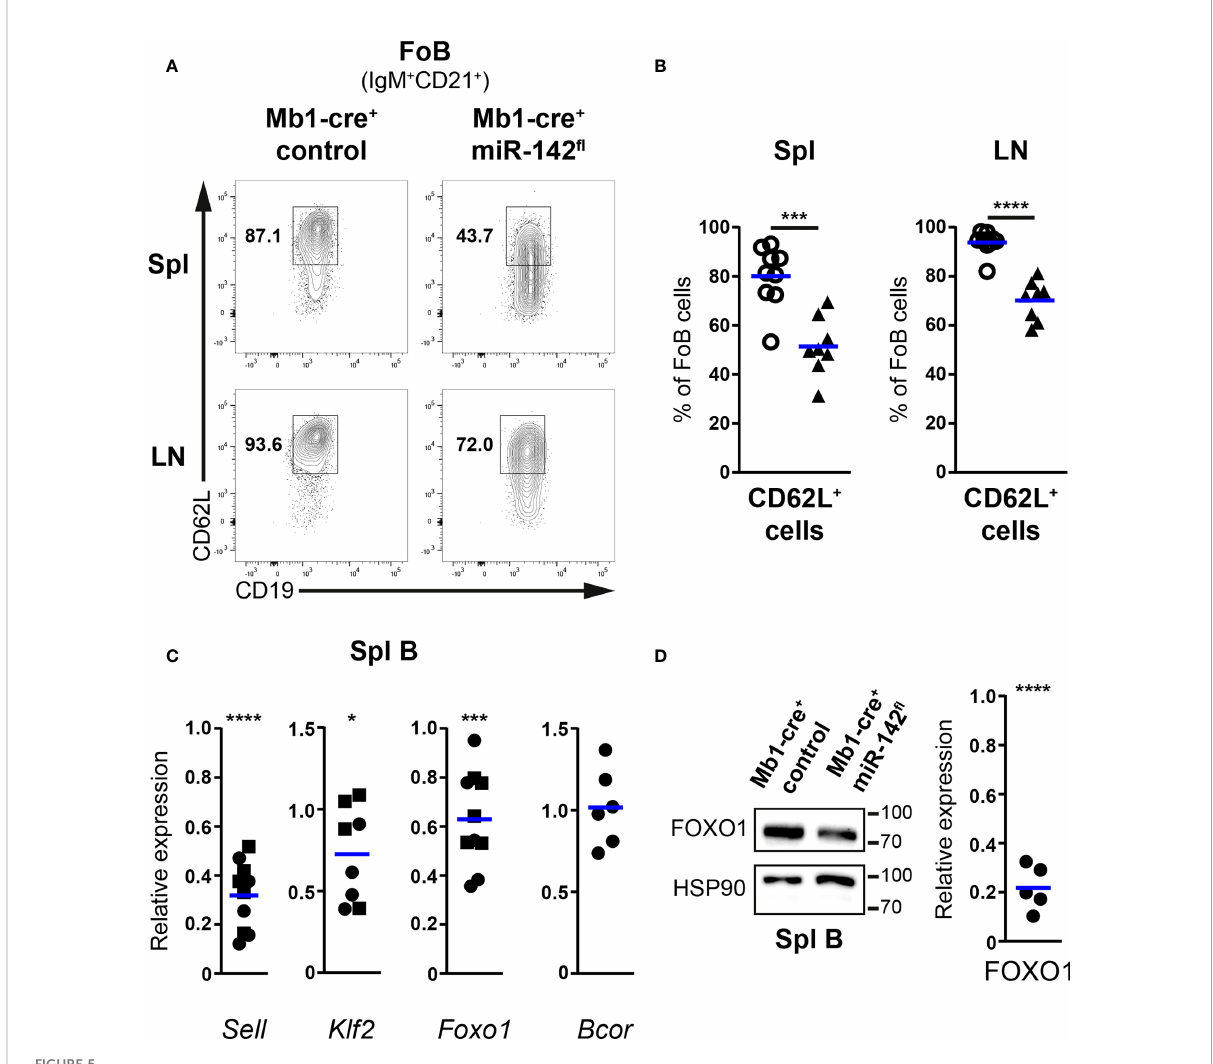
FIGURE 5 CD62L expression is impaired in follicular B cells of Mb1-cre + miR-142 fl mice. (A) fl ow cytometry of CD62L + cells within IgM + CD21 + CD19 + B220 + CD93 – follicular B (FoB) cells in the spleens (Spl) and lymph nodes (LN) of Mb1-cre + control and Mb1-cre + miR-142 fl mice. (B) Proportions of CD62L + Fo B cells in Spl and LN of Mb1-cre + ( ○ ) and Mb1-cre + miR-142 fl ( ▲ ) animals. n = 8-9 per group in 9 independent experiments. (C) Real-time PCR of Sell , Klf2 , Foxo1 and Bcor mRNA levels in magnetically-puri fi ed splenic B cells from Mb1-cre + miR-142 fl mice. Normalized to Hprt transcript levels and to their respective expression in Mb1-cre – ( n=4-5 , ◼ ) and Mb1-cre + ( n=4-6 , ● ) controls. Cumulative of 15 independent pairs of mice. (D) Left: Western blotting of FOXO1 and loading control HSP90 in splenic B cells magnetically-isolated from Mb1-cre + and Mb1-cre + miR-142 fl mice. Right: Quanti fi cation of FOXO1 protein levels in splenic B cells from Mb1- cre + miR-142 fl animals. Normalized to the expression of HSP90 and to the relative levels of FOXO1 in Mb1-cre + controls. n = 5, pooled from 5 independent pairs of mice. Each symbol represents one mouse (B) or a ratio between a pair of control and mutant animals (C, D) . (B – D) Horizontal blue lines indicate means. *, P ≤ 0.05; ***, P ≤ 0.001; ****, P ≤ 0.0001 by Student ’ s t test (B) and one sample t test (C, D) . (C) Excluded from the analyses: two Klf2 datapoints due to bad signals in the control